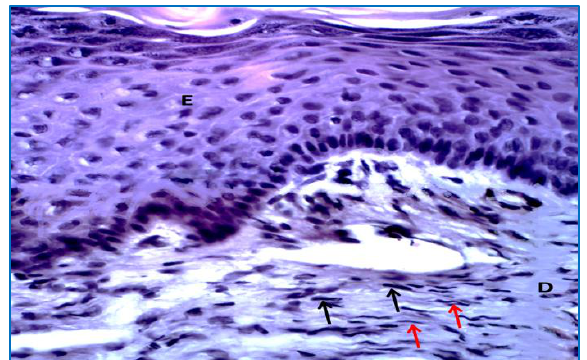
Figure, 13: Magnified section of skin (14 days post treatment with amniotic membrane) shows epidermis (E), dermis (D), and well organized fibroblast and collagen bundles (Black arrows) and fibrocytes (red arrows). H and E,400x.